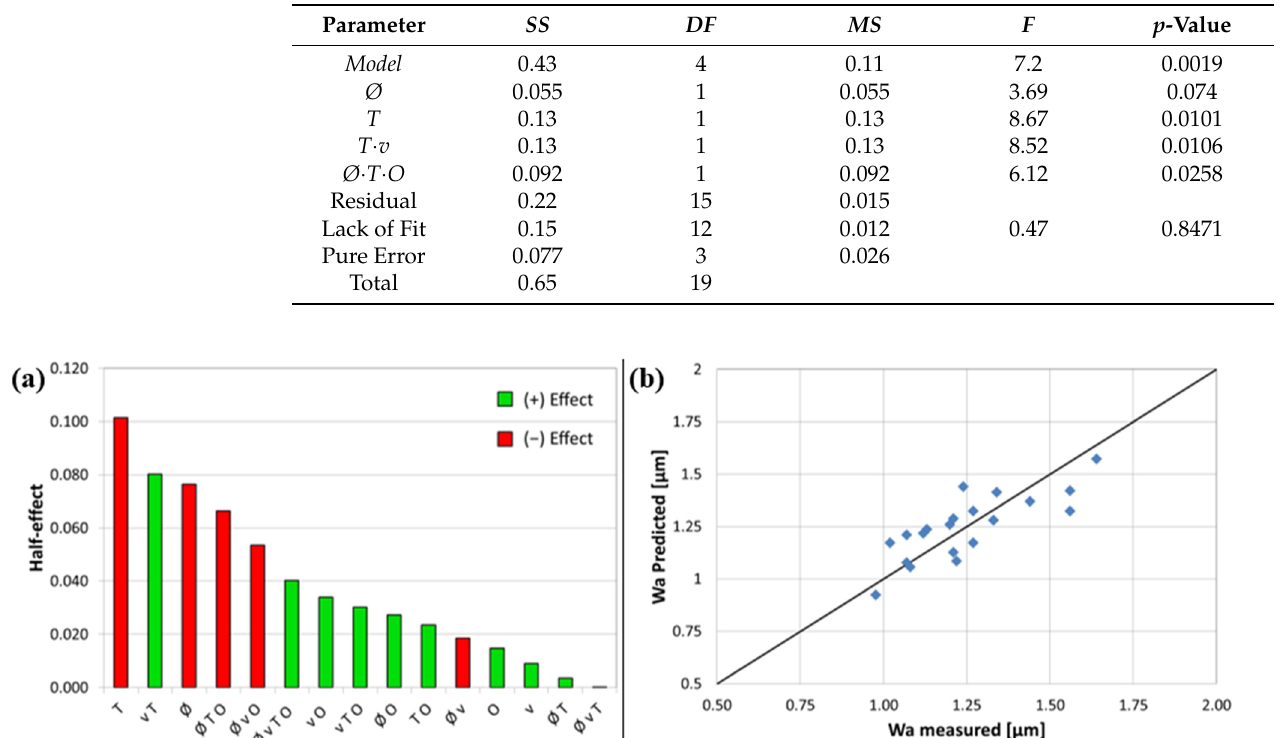
Table 6. Analysis of variance ( ANOVA ) for Ra ( SS : Sum of square; DF : degree of freedom; MS : mean square).